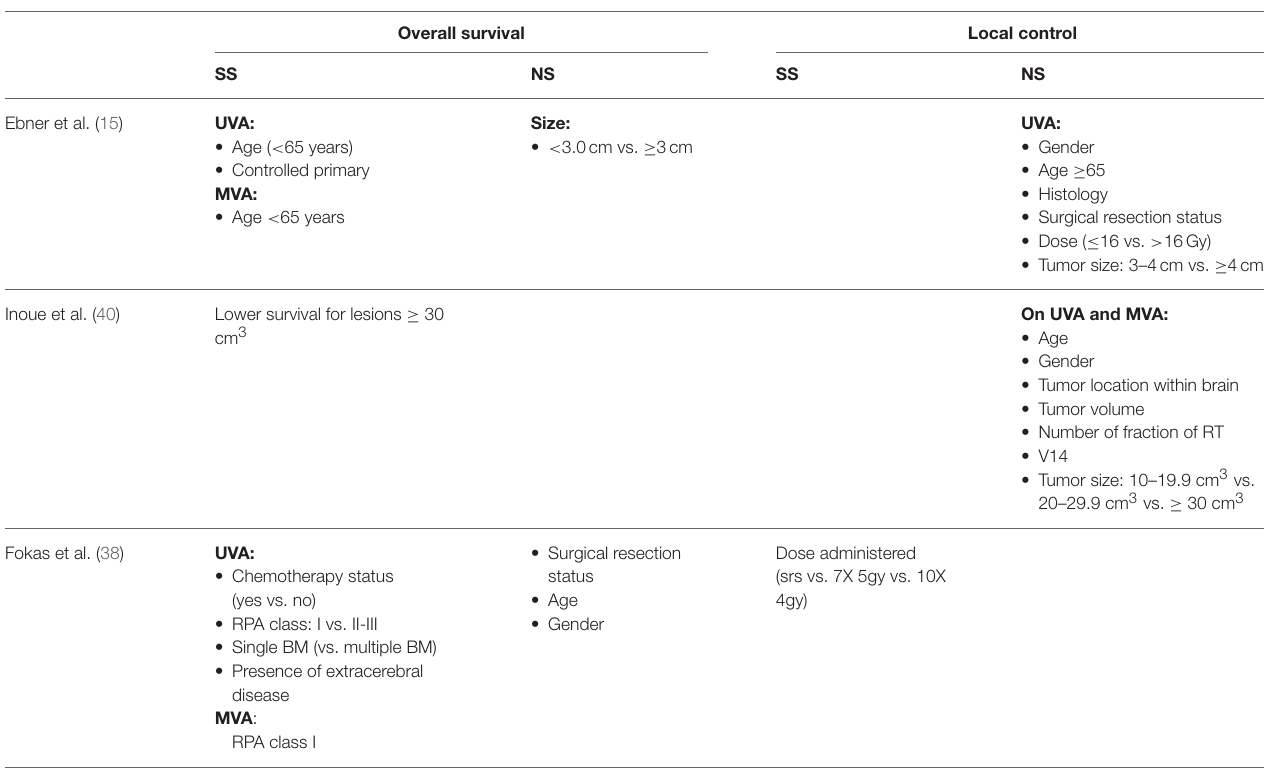
TABLE 2 | Selected series with factors influencing OS and local control in patient treated with